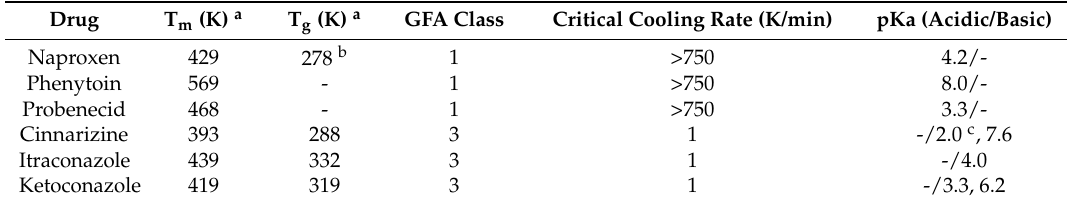
Table 1. T m , T g , classification of glass forming ability, critical cooling rate and pKa of the investigated drugs.